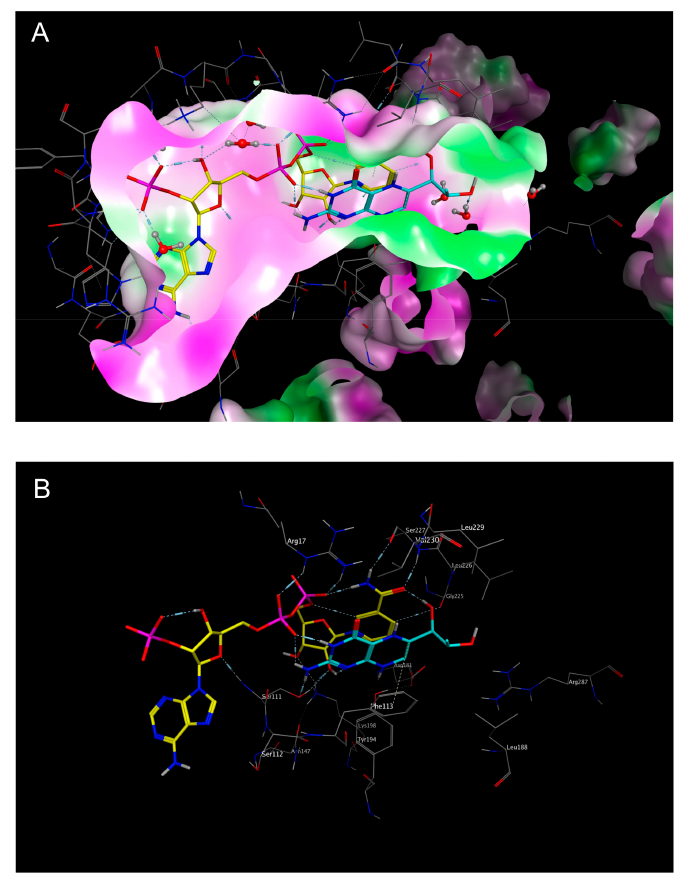
Figure 5. Representation of the catalytic site of Lm PTR1 (PDB-ID “2BF7”), with the co-crystallized nicotinamide adenine dinucleotide (NADP + ) shown in yellow, and the co-crystallized substrate dihydrobiopterin (DHB) (7,8-dihydrobiopterin) shown in cyan. ( A ) The molecular surface of the binding site was colored according to lipophilicity, with green indicating high lipophilicity, and purple indicating low lipophilicity. Note the π -stacking interaction of the pteridine system with the nicotinamide moiety of NADP + , as well as the formation of H-bonds with one phosphate group of the co-crystallized co-substrate; ( B ) Surface not shown, but amino acid residues